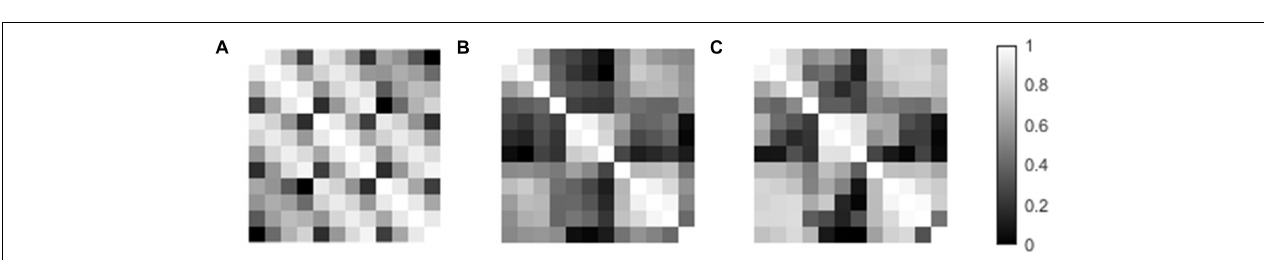
FIGURE 4 | Comparison between the phantom image and in vivo contrast-to-noise ratio (CNR)-mimicked image. (A) Artifact positions under different lead orientations in the phantom image. (B) Artifact positions under different lead orientations in the phantom image, which added an artificial noise to mimic the in vivo condition. (C,D) Localization error of the original phantom image and phantom image-added artificial noise. Horizontal axis indicates the θ angle. Three curves represent different ϕ angles. Both θ and ϕ angles contribute to the deviation, and reduction of either of the angles can achieve a better accuracy.